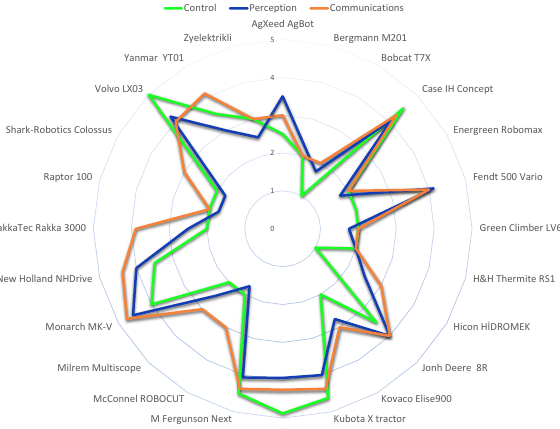
Table 1. Relevant MIM chosen to serve as technological baseline, its original field of application, development stage and